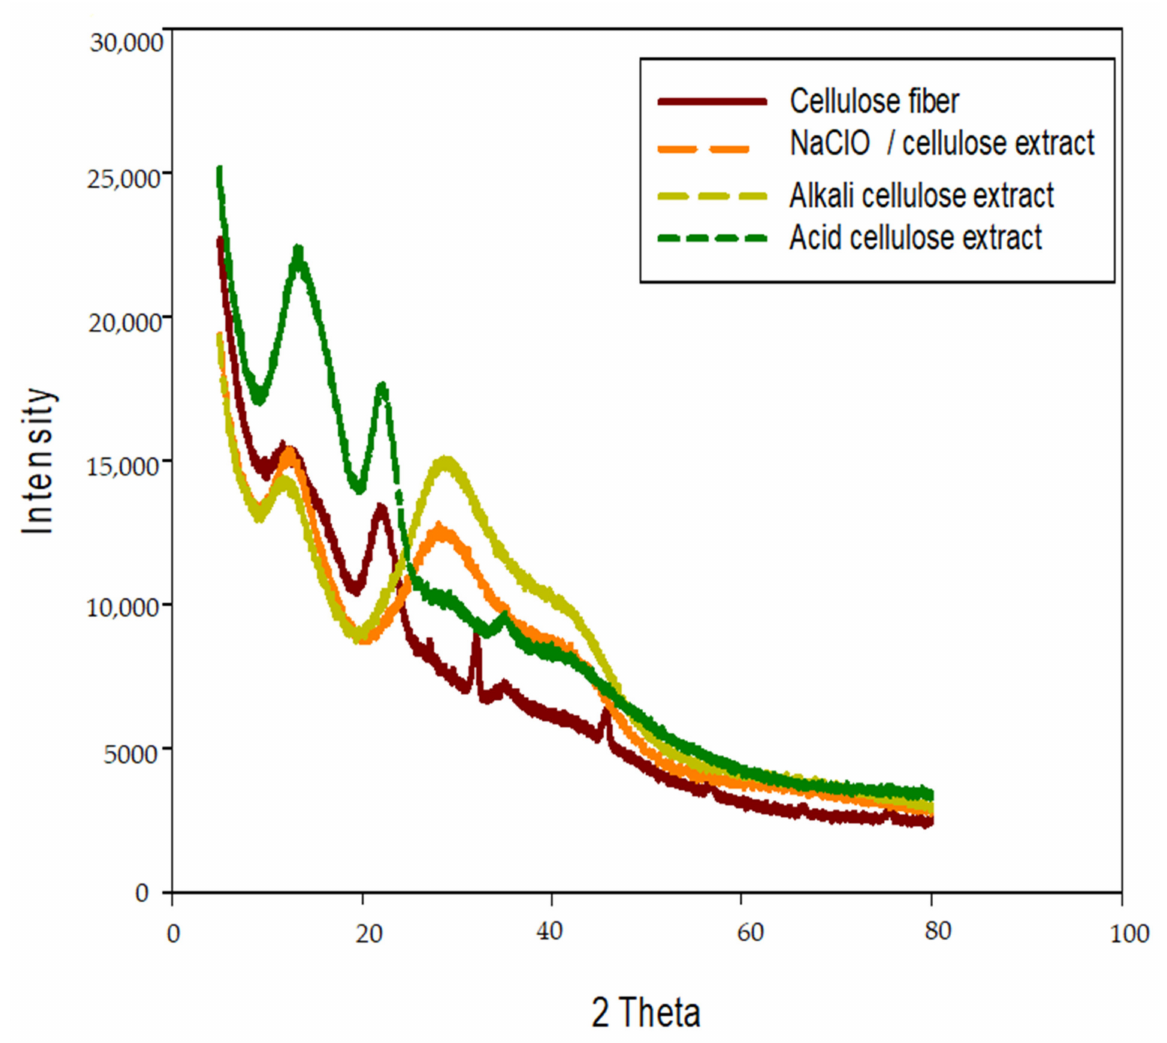
Figure 4. X-ray diffractions of cellulose fiber and nanocellulose after treatment by ultrasonic